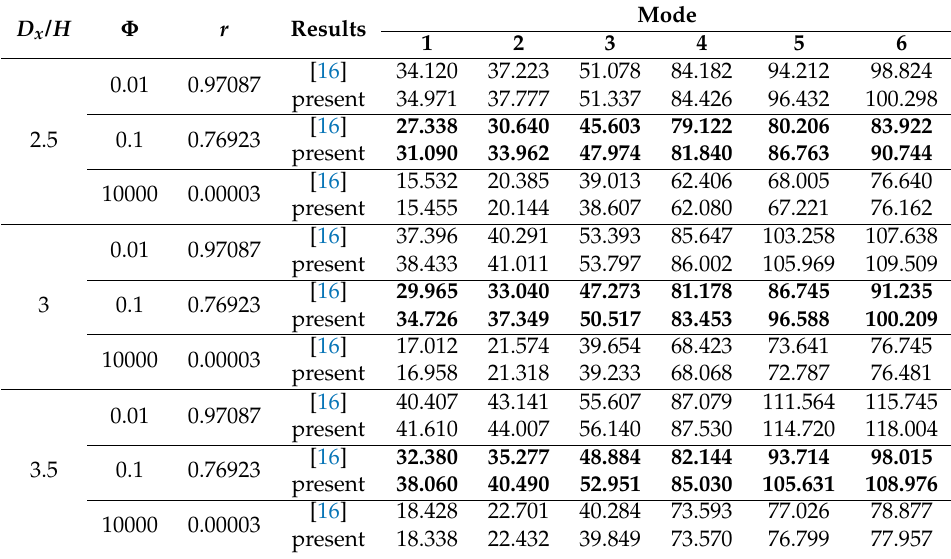
(cid:112) ρ h / H for orthotropic plates with various flexural